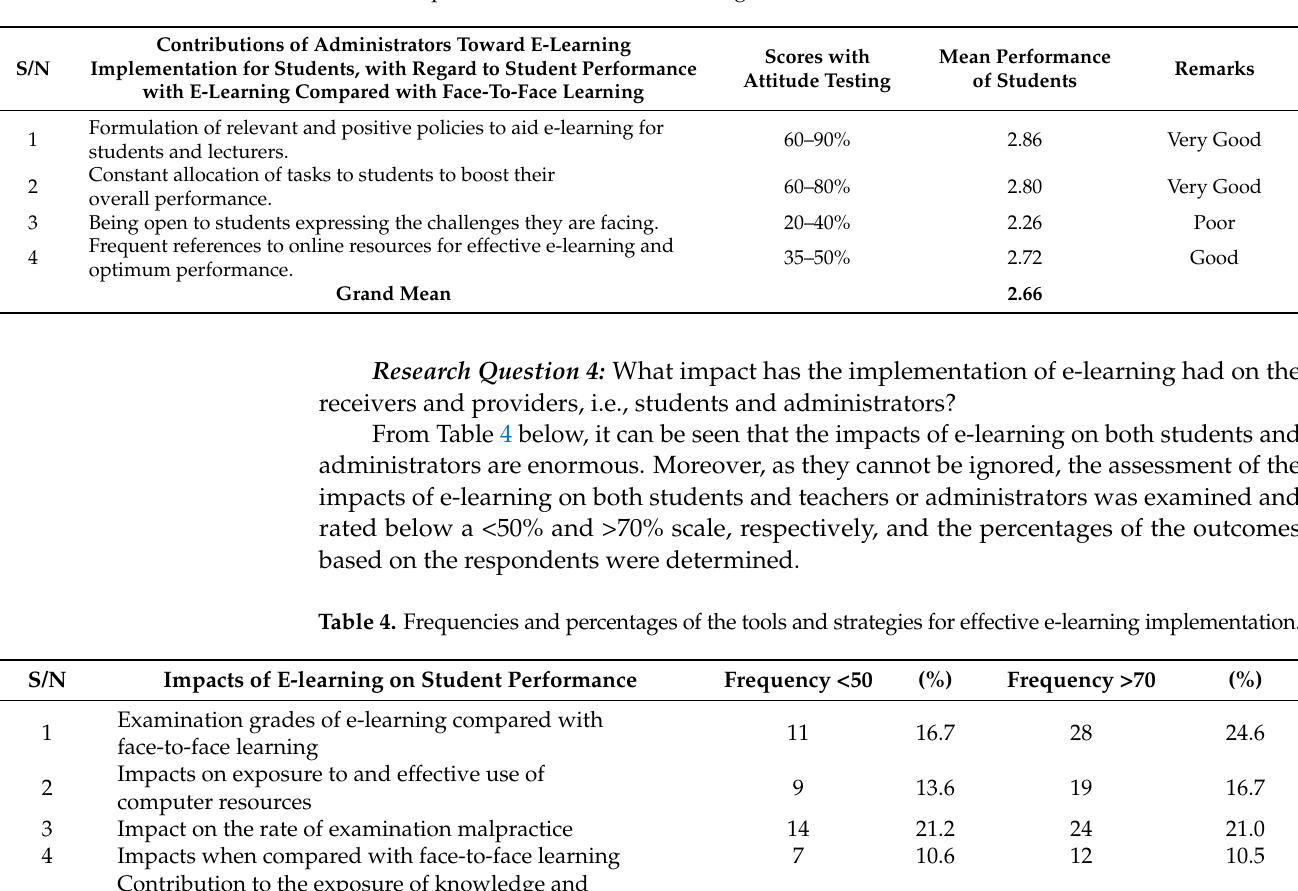
Table 3. The mean performance and remarks on the contributions of administrators towards perfor- mance compared with face-to-face learning.